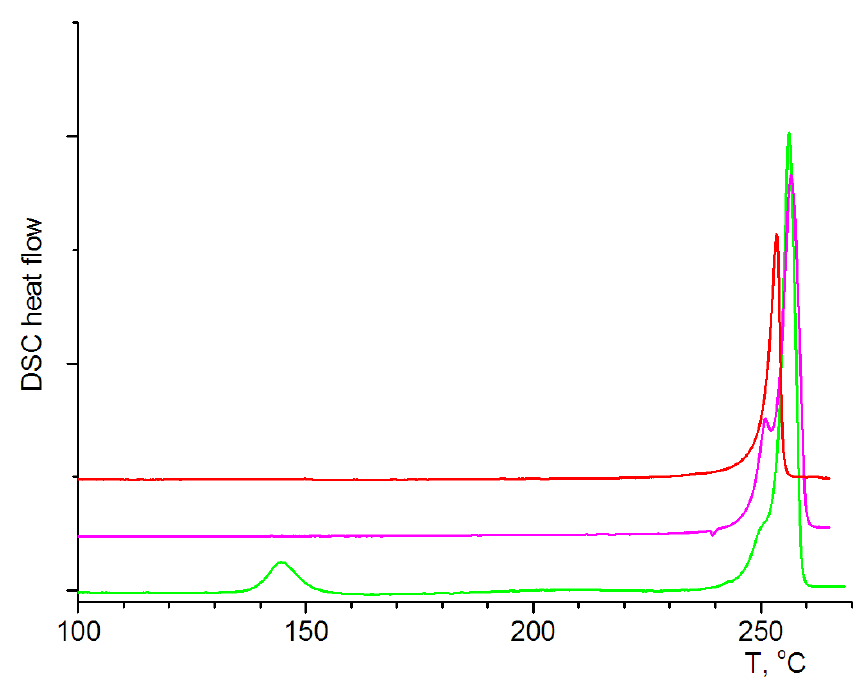
Figure 5. The DSC curves of polymer 2 in the direct mode (green line), of the crystallized melt sample rescan mode (pink line), and of the solid phase 2a (red line). According to the DSC, the solid-state transformation of polymer 2 into polymer 2a occurred at 138.2 ◦ C (endothermic peak) without the decomposition of the sample. Further melting, as a complex endothermic event, was observed at 251.7 ◦ C. The rescan of